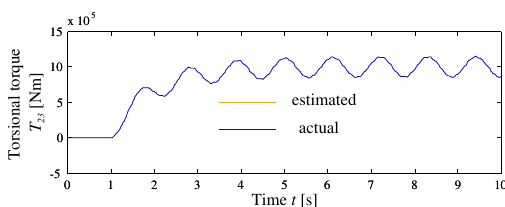
Figure 8. Torsional torque at without parameter error.